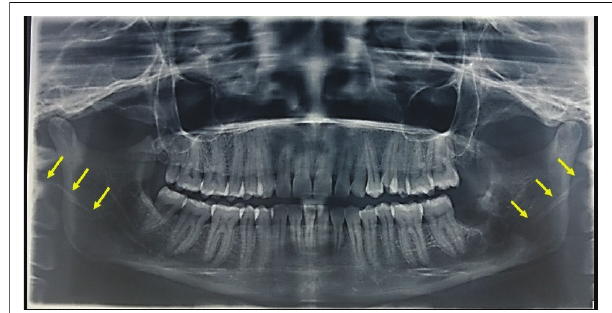
FIGURE 3: Digital orthopantomogram showing the presence of bilateral elongated styloid